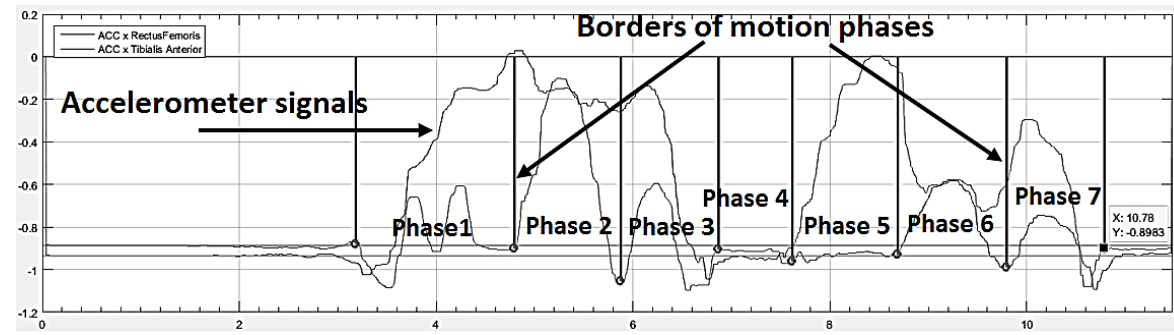
Figure 6. The determination of the motion phases using the accelerometer signals of the muscles Rectus Femoris and Biceps